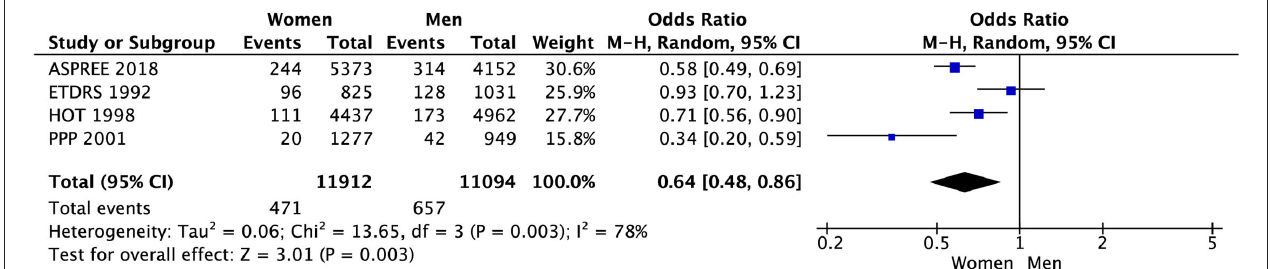
FIGURE 9 | Mortality in women and men taking aspirin.